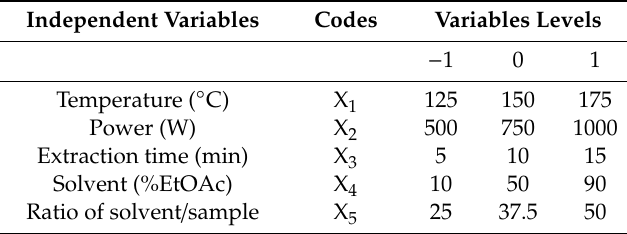
Table 1. Independent variables and their levels.